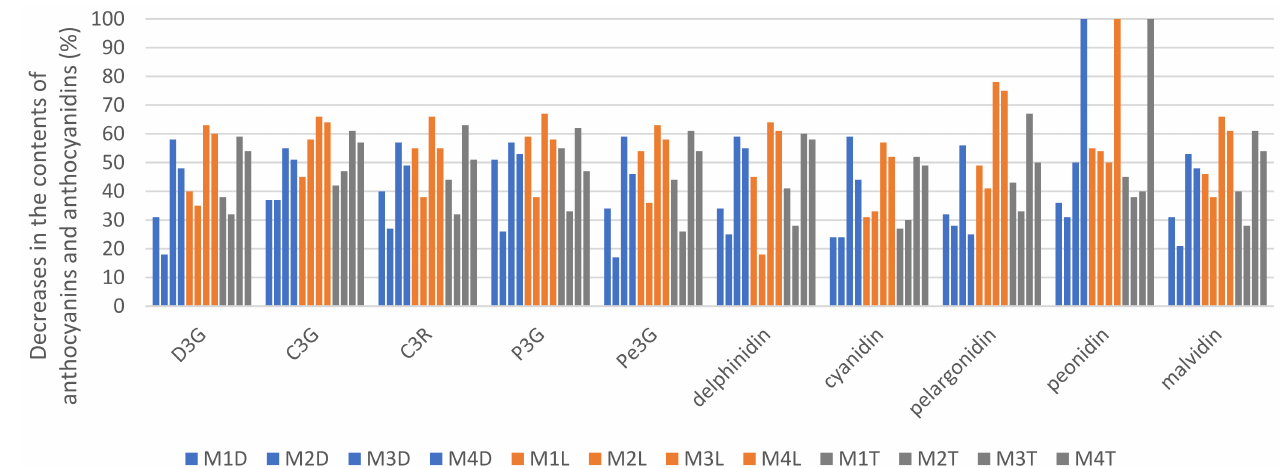
Figure 5. Percentage decreases in the contents of anthocyanins and anthocyanidins of the M1–M4 nutraceutical mixtures under the defined storage conditions: D3G (delphinidin-3-glucoside), C3G (cyanidin-3-glucoside), C3R (cyanidin-3-rutinoside), P3G (pelargonidin-3-glucoside), Pe3G (peonidin- 3-glucoside), D (storage without sunlight, blue color), L (storage in the presence of sunlight, orange color), T (storage in thermostatic device, grey